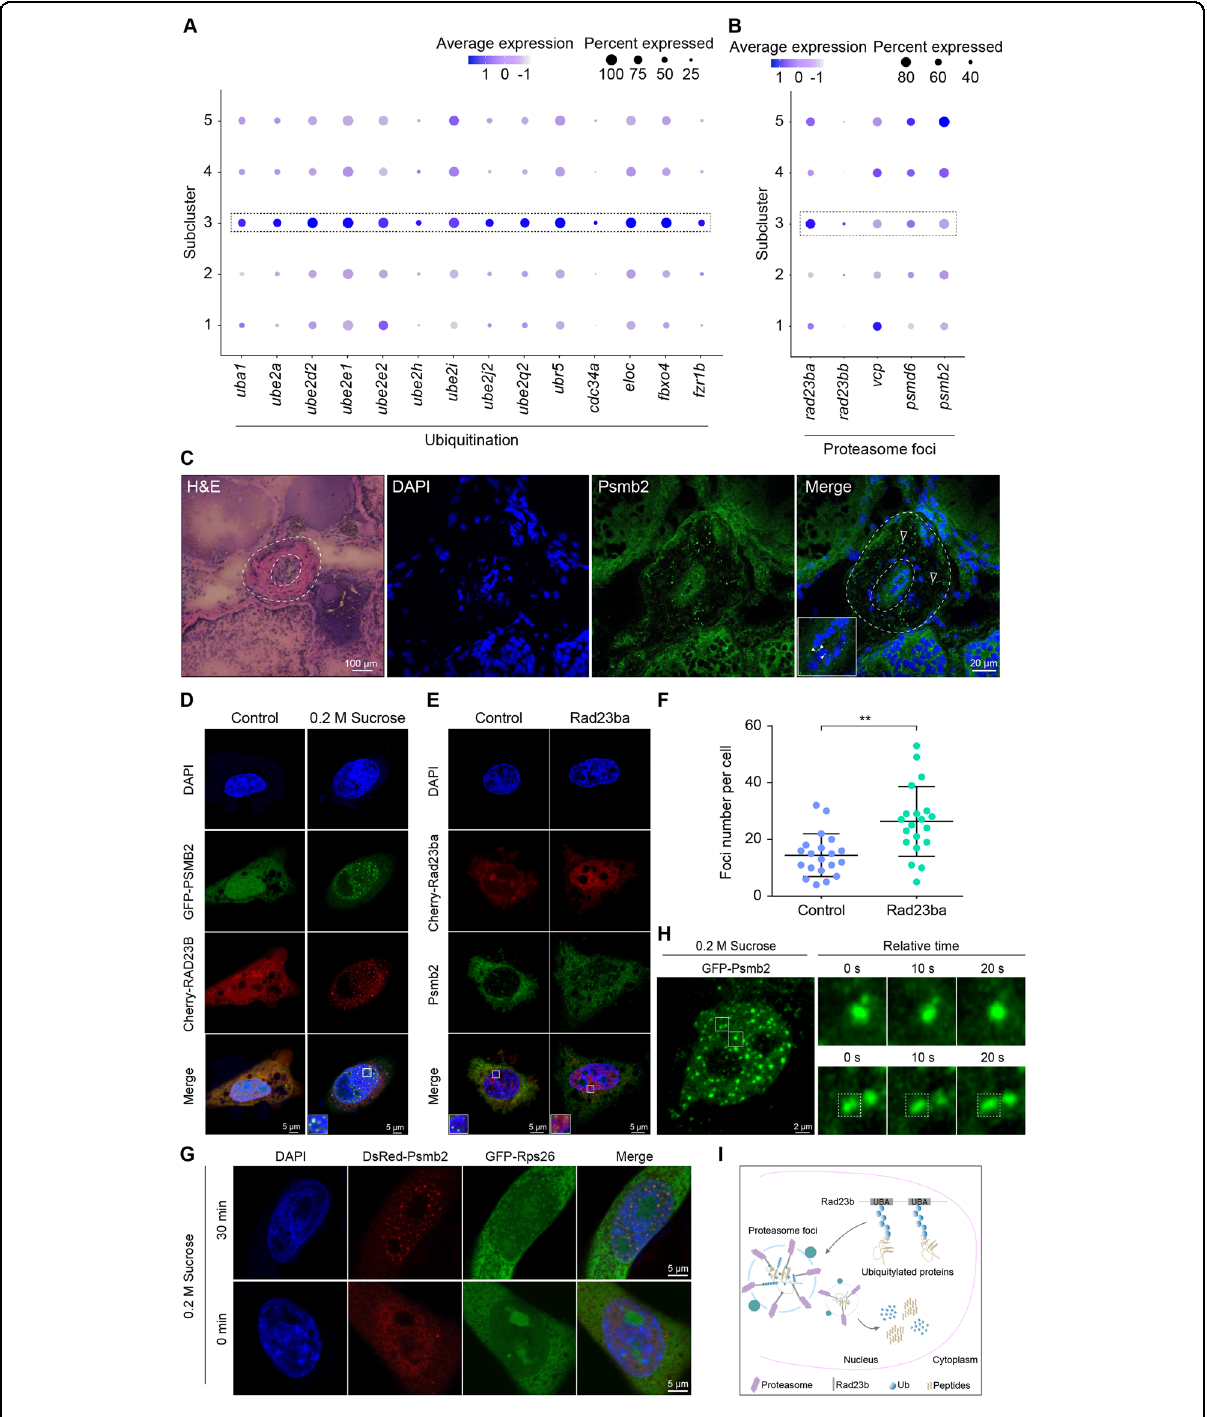
Fig. 2 (See legend on next